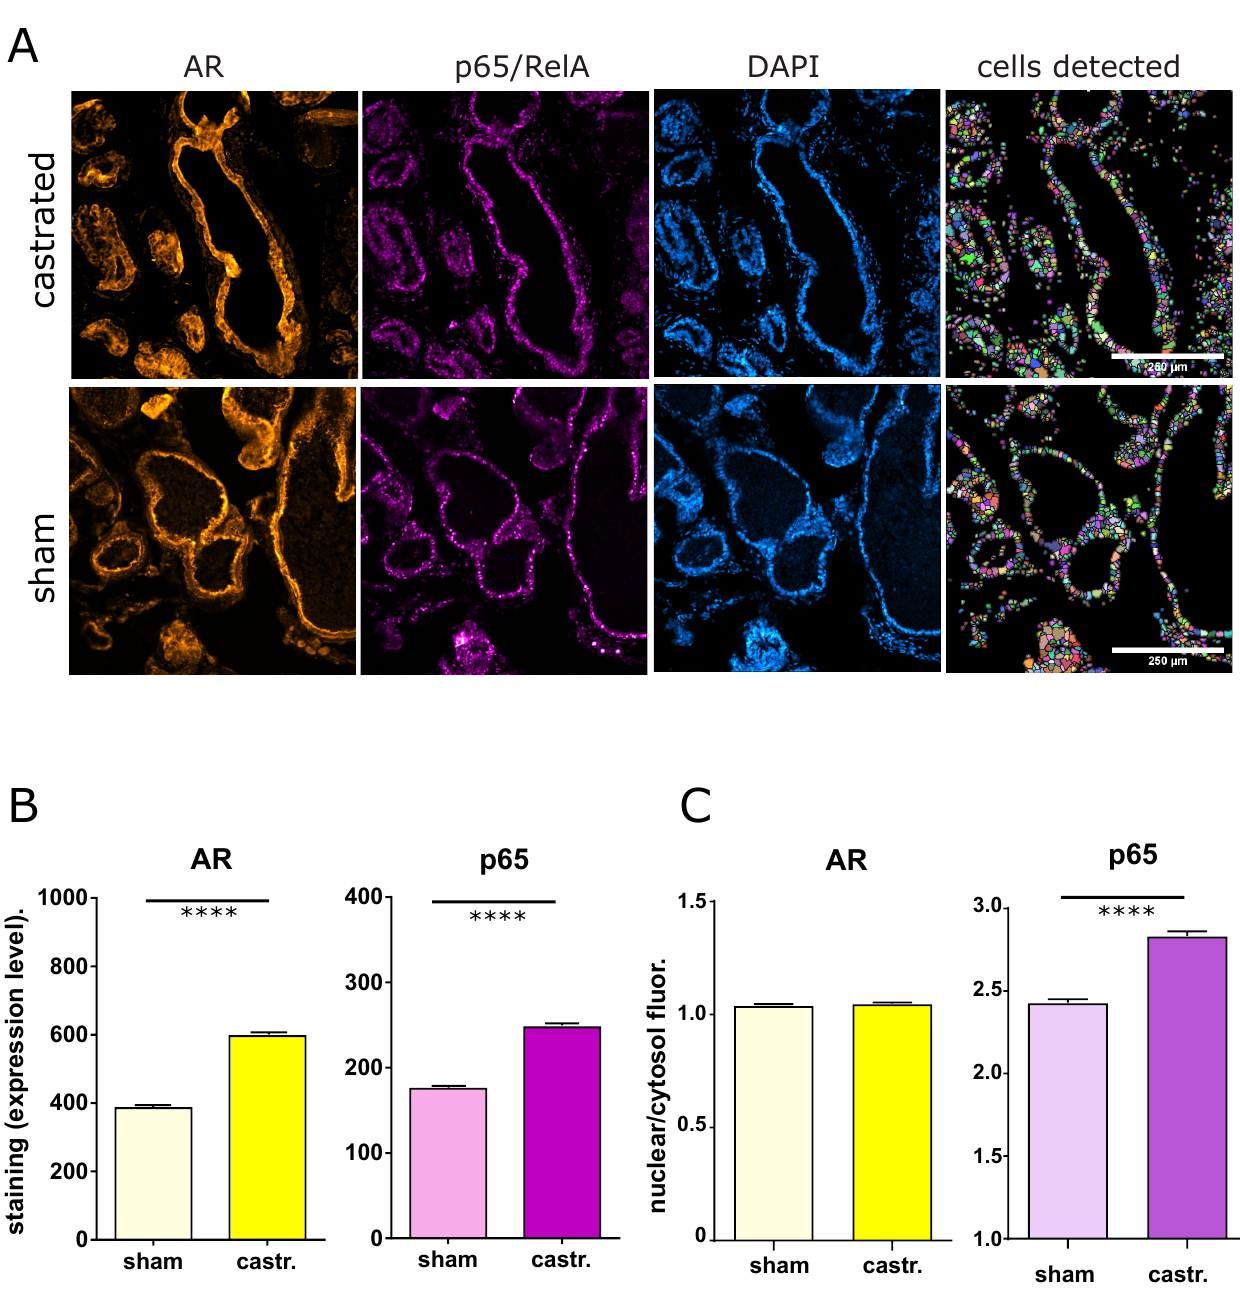
Figure 5. Immune-fluorescence microscopy of AR and p65 in castrated versus sham-operated mice. ( A ) Representative fluorescence microscopy images of prostate tissue sections from C57BL/6 mice (castrated or sham-operated) stained for AR, p65/RelA (NF- κ B), and DAPI (for DNA and cell recognition). The right panel shows the cell masks detected with the IKOSA-image analysis platform (see Section 2) The scale bar indicates 250 µ m. Samples from castrated mice (castr.) comprised 6 sections, from which 33 view fields were captured for the three fluorescence microscopy channels.